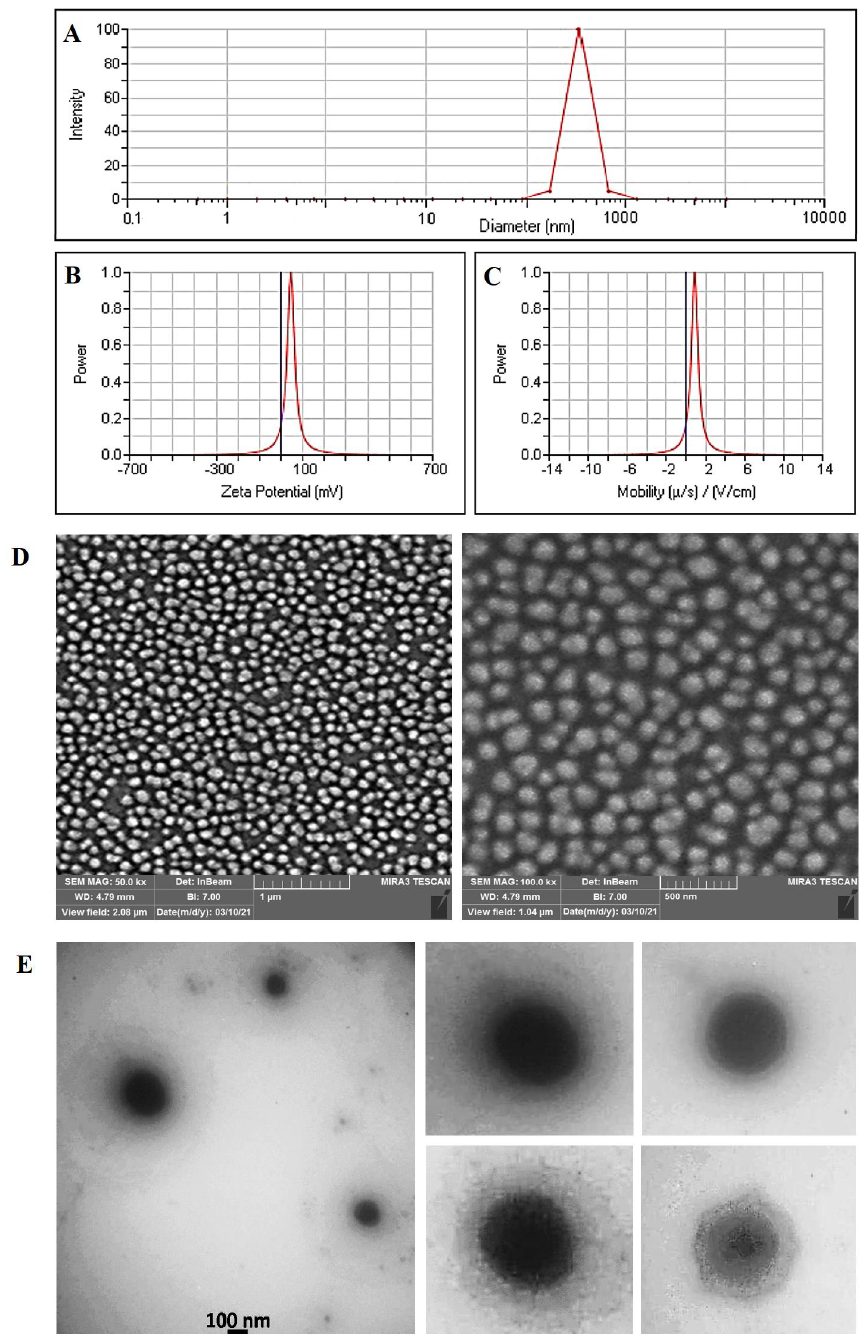
Figure 6. Physical characterization of TAM/RES–LbL-LCNPs: ( A ) Dynamic Light Scattering (DLS) analysis, ( B ) zeta potential analysis, ( C ) mobility analysis, ( D ) FE-SEM with a scale bar of 1 µ m and 500 nm, respectively, and ( E ) TEM images with selected particles of synthesized TAM/RES–LbL- LCNPs (as presented in the right